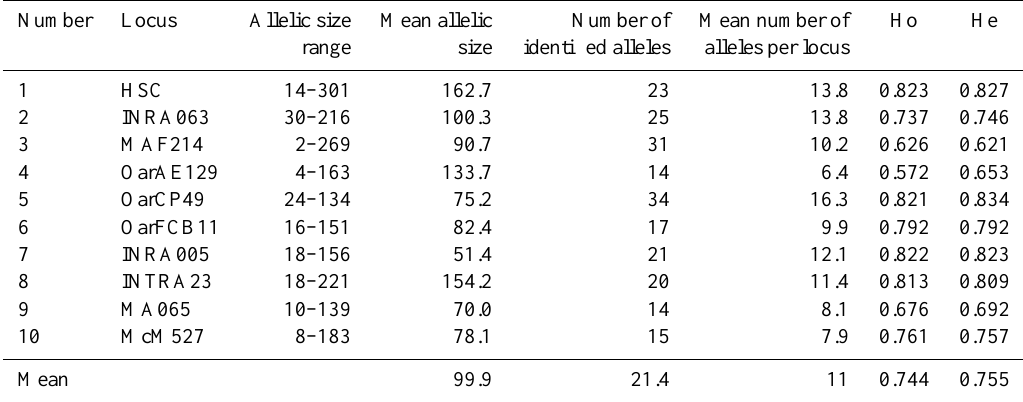
Table 2. List of microsatellite markers used, allelic size, number of identified alleles, mean number of alleles per locus, and observed (Ho) and expected (He) heterozygosity for each locus for the whole population. Number Locus Allelic size Mean allelic Number of Mean number of Ho He range size identified alleles alleles per locus 1 HSC 14–301 162.7 INRA063